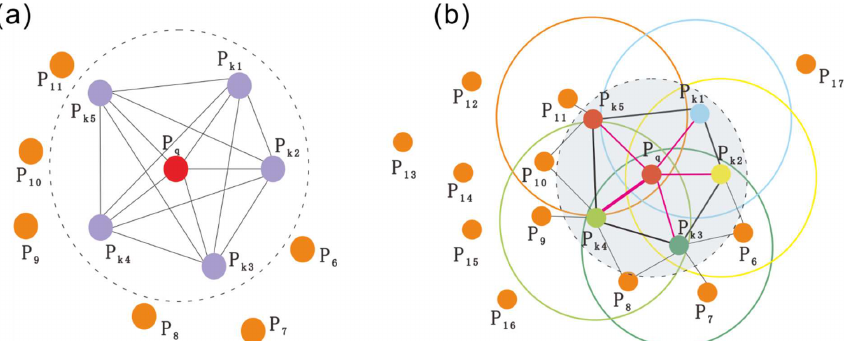
Figure 9. Schematic diagram of PFH and the FPFH calculation area. ( a ) is the calculation area map of PFH, where the query point (red) is fully interconnected with its K neighbors (purple) in the neighborhood; ( b ) is the calculation area map of FPFH, where the query point (red) is connected only to its immediate K-neighbor (circled in gray); the direct K-neighbor point is connected with its own K-neighbor point, and the histogram obtained is weighted with the histogram of the query point to form FPFH. Adapted with permission from ref. [51]. Copyright 2009 Copyright Rusu. The calculation is shown as follows: